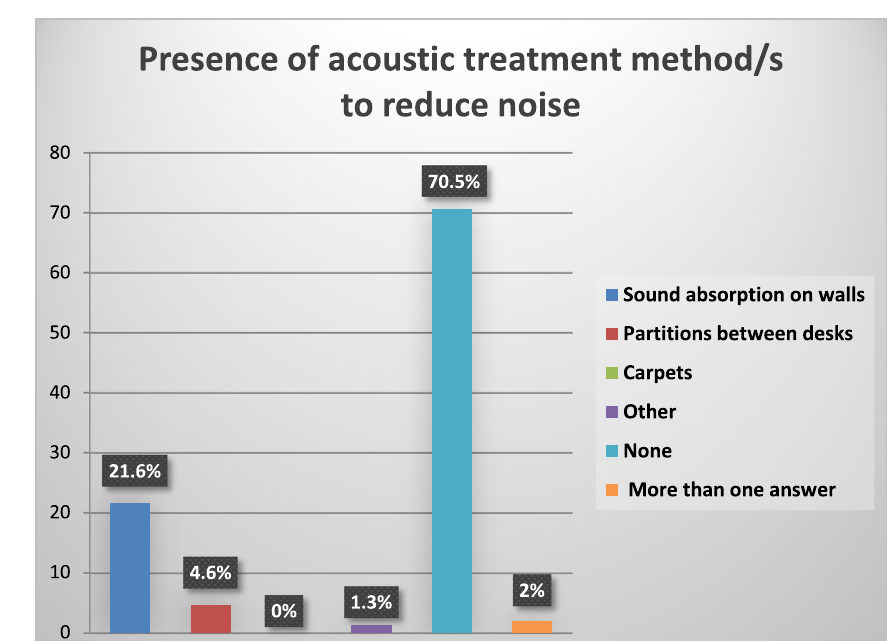
Fig. 4 The presence of acoustic treatment methods to reduce